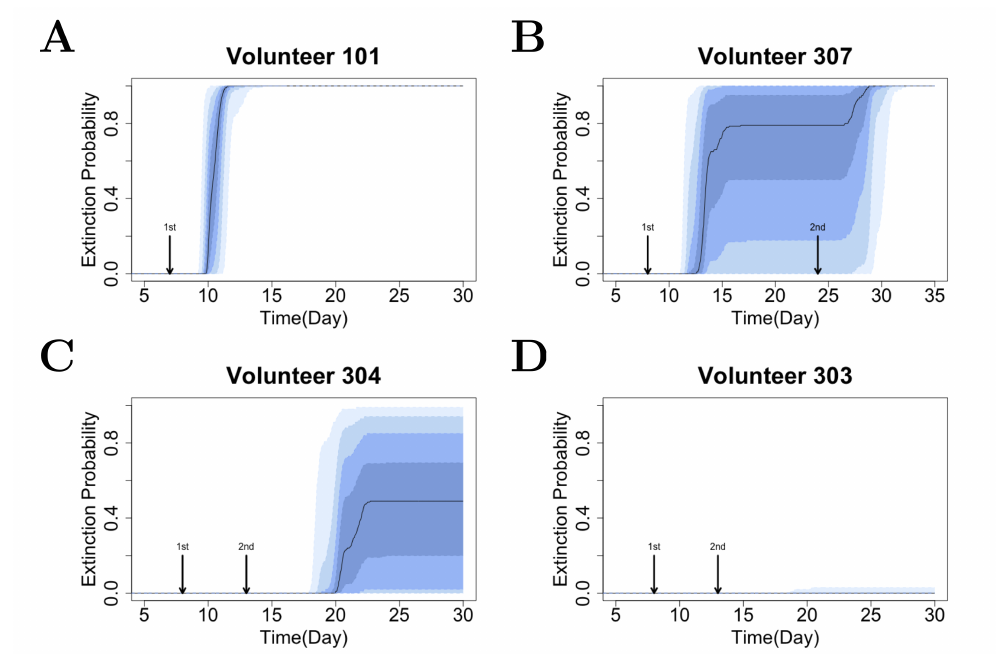
Figure 4. Model-predicted time series of extinction probabilities for volunteer 101 (panel A ), 307 (panel B ), 304 (panel C ) and 303 (panel D ). The median (solid curve) and 25%, 50%, 75% and 95% PI (shaded area) were generated by simulating the stochastic model using 1000 samples selected from the 5000 posterior samples generated by Cao et al. [9] For each of the 1000 selected samples the stochastic model was simulated 100 times and the extinction probability was given by the proportion of extinction events in the 100 realisations as described in Materials and methods. Arrows indicate the administration times of the first or the second (if any) dose of